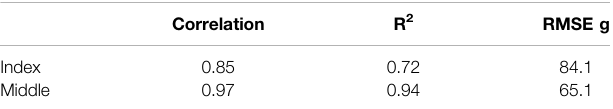
TABLE 2 | Evaluation results of the experiment. Correlation, R 2 , and RMSE of the index and middle fi ngers, respectively, calculated by summing up the results of all subjects are